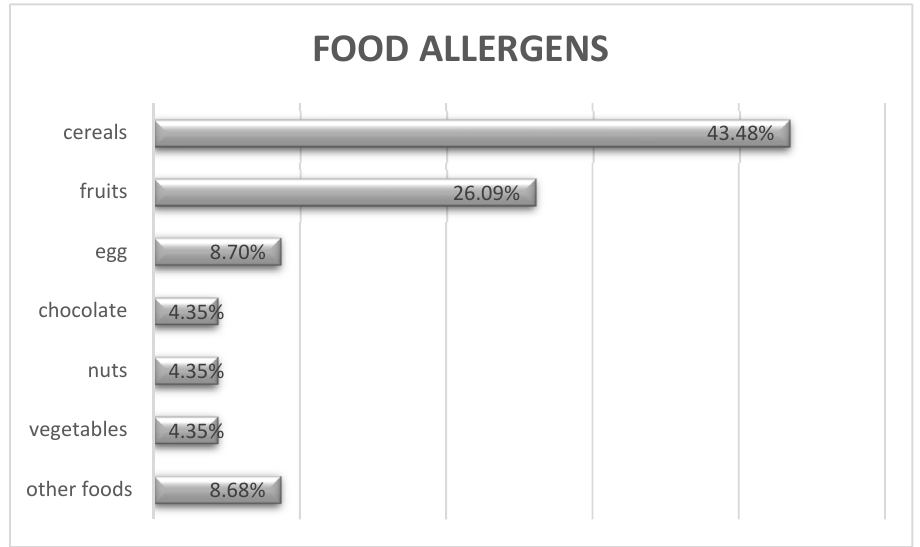
Figure 1. Food allergic reactions per food allergen, according to the school medical card, as reported by parents/carers ( N = 68).